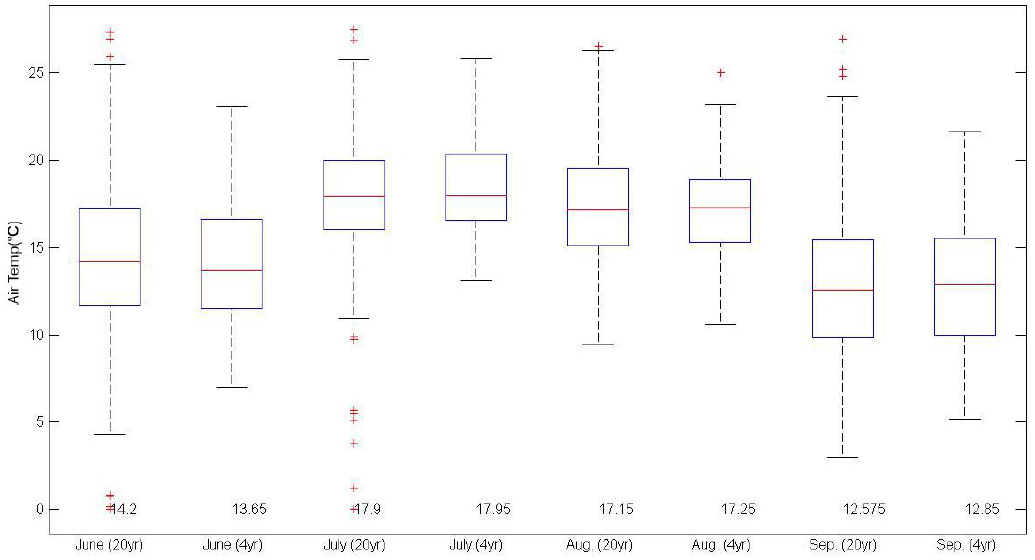
Figure 3. Box plot of air temperature with 20 historical years and the four years with temperature